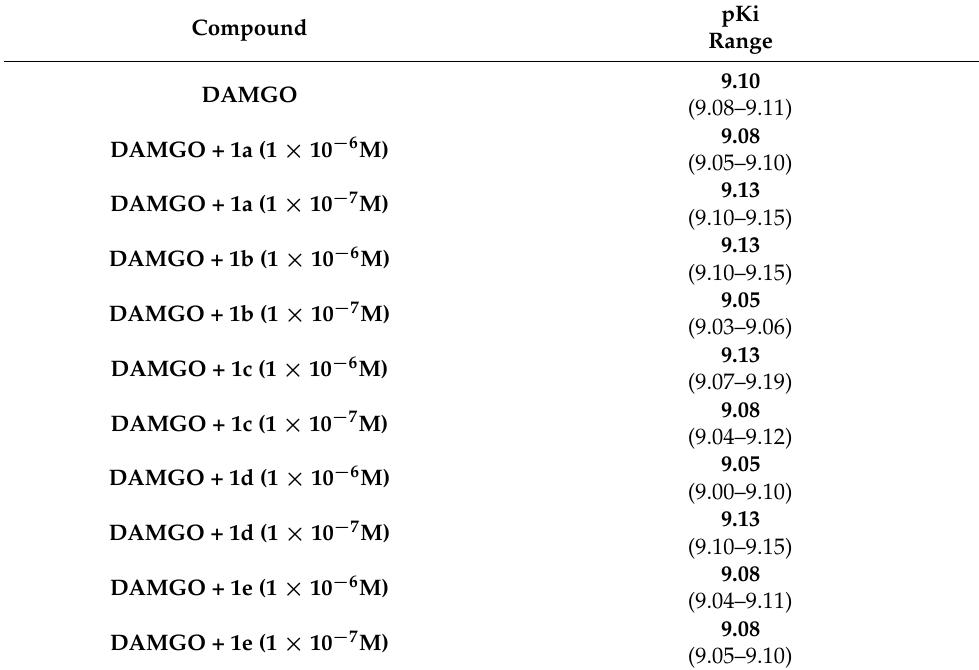
Table 2. Effect of the tested compounds on the affinity of DAMGO for the MOP. Compound